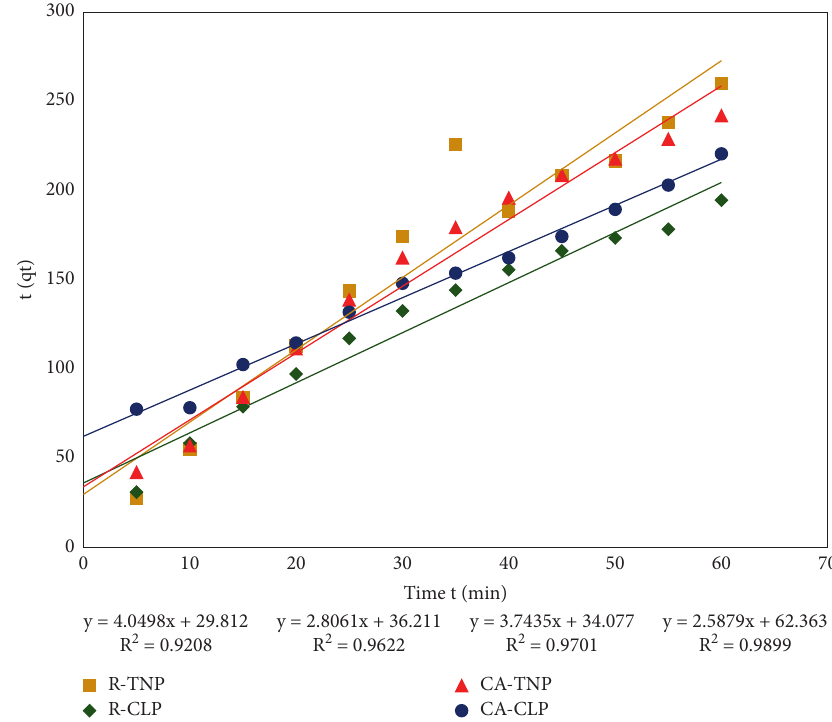
Figure 16: Comparison of pseudo-second-order-kinetics for adsorption. Time period � 5 to 60min, adsorbent dose � 0.5g, temper- ature � 30 ° C, agitation speed � 100rpm, initial pH � 5, final pH: R-TNP � 5, R-CLP � 4.5, CA-TNP � 4.0, and CA-CLP � 4.0, and dye solution volume V �